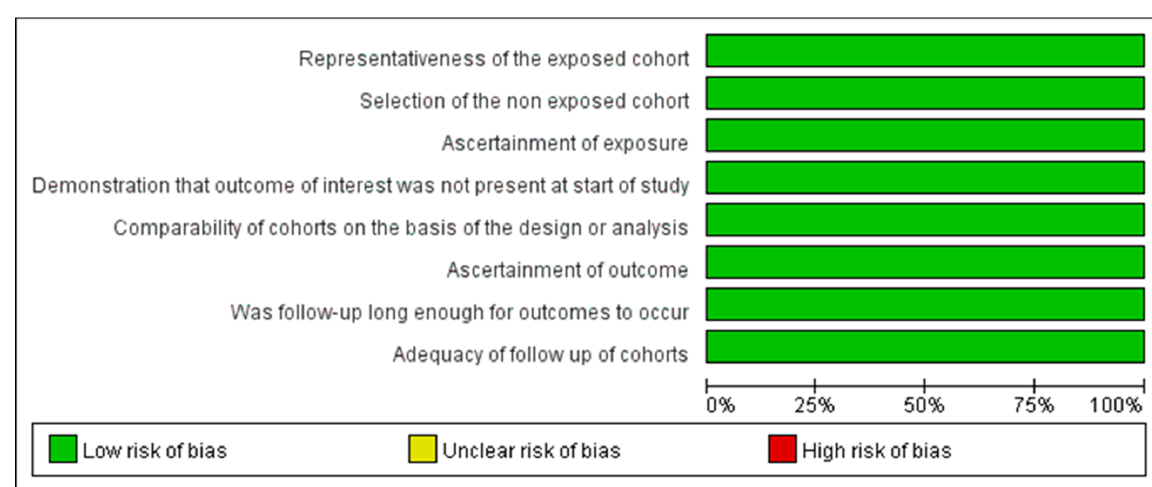
Figure 2. Quality assessment of the included cross-sectional studies.